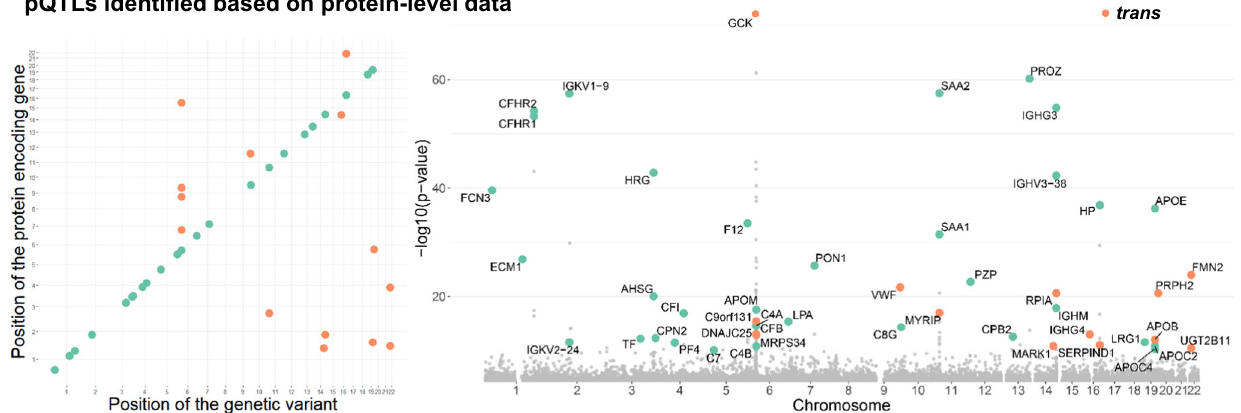
Fig. 2 | Gene – protein associations based on protein-level data. The left plots show the position of genetic variants against the position of the coding gene. The Manhattan plots (right) show the sentinel pQTLs and associated proteins. The green dots represent cis -pQTLs, while the red dots represent trans -pQTLs.